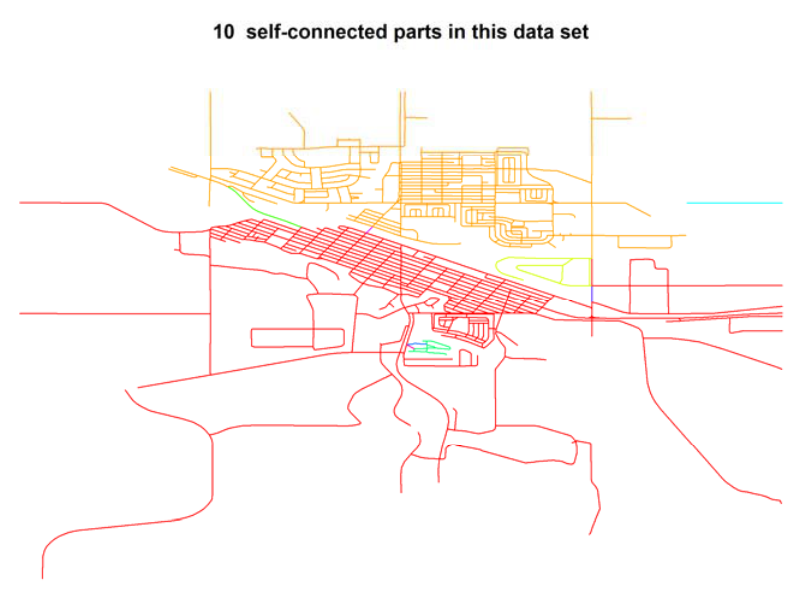
Figure 5. Connectivity of the Estevan road network via the function nt.connect .